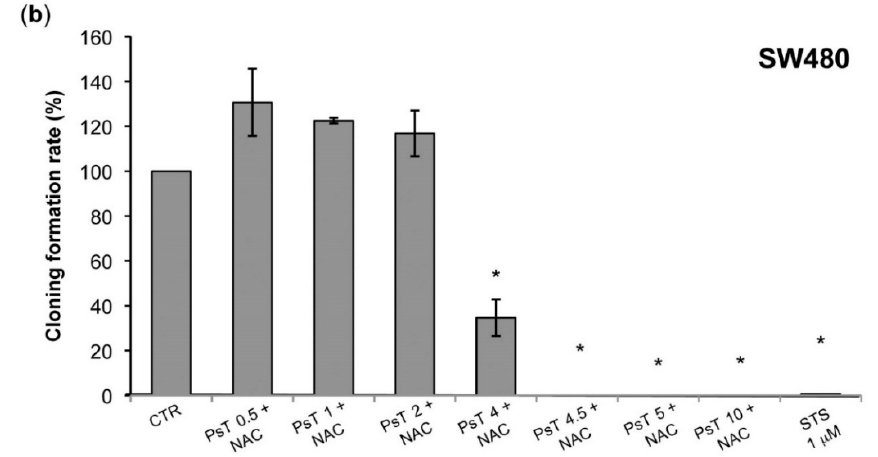
Figure 4. Clonogenic effect evaluated on HCT116 and SW480 cells after (PsT 0.5–10 mg/mL + NAC) ® treatments for 24 h. Staurosporine (STS, 1 µ M) was used as positive control. All experiments were performed at least three times. One-way ANOVA was applied. * = significant difference compared to control cells p < 0.001.